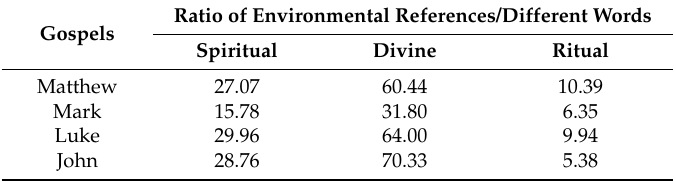
Table 13. Ratio of environmental references/unique words of the spiritual environment. Ratio of Environmental References/Different Gospels